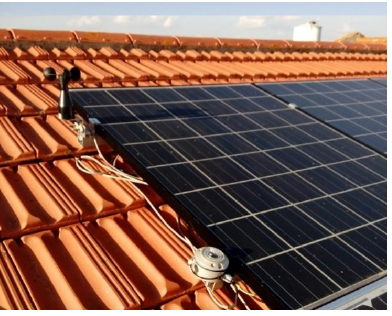
Figure 5. Pyranometer and anemometer installed on the